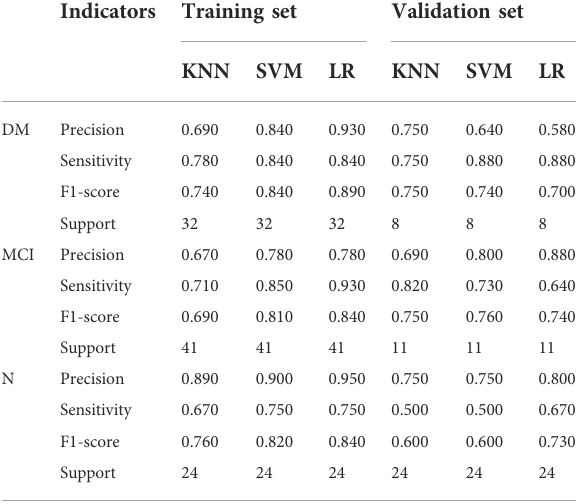
TABLE5Theresultsoffourindicators-Precision,Sensitivity,F1-score, Support in training, and validation set. Indicators Training set Validation